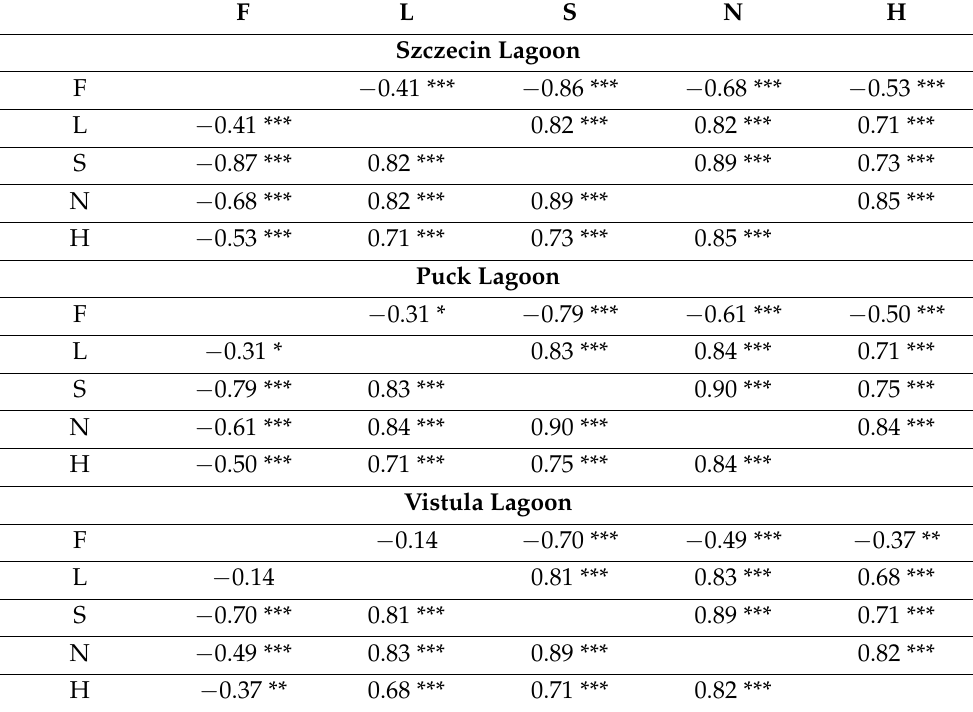
Table 4. Correlation coefficients between the individual ice parameters (designations as in Table 2) in southern Baltic coastal lagoons